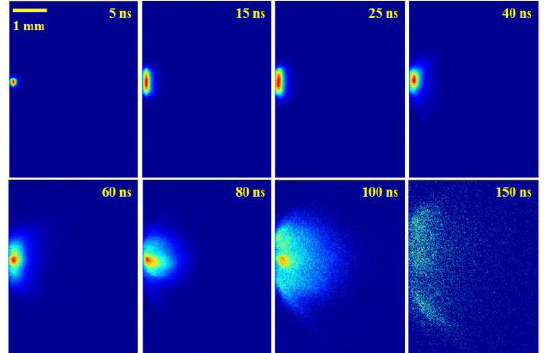
Fig. 2. Time sequence of fast photography images showing the spatio-temporal evolution of the plume at various